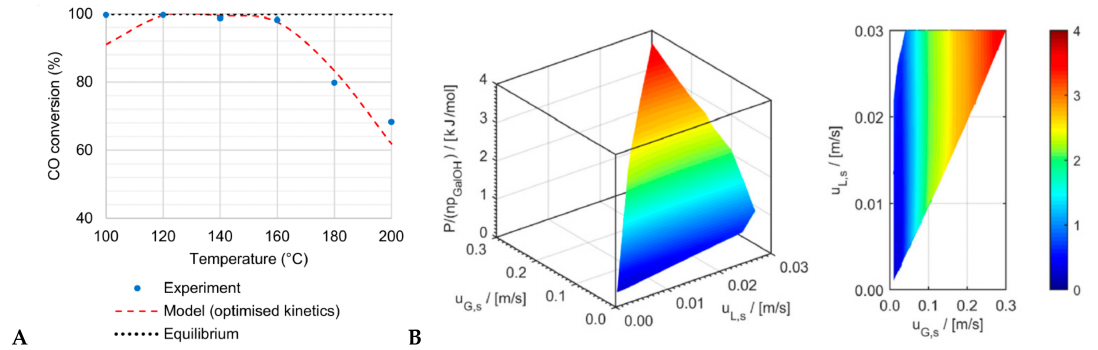
Figure 3. ( A ) CFD model validation to experimental data of CO conversion, in the temperature range 100–200 °C, and for space velocities of 32.6 NL/(g cat h) [4]. ( B ) Specific energy consumption of mini trickle-bed reactors operating at different gas and liquid superficial velocity [5].